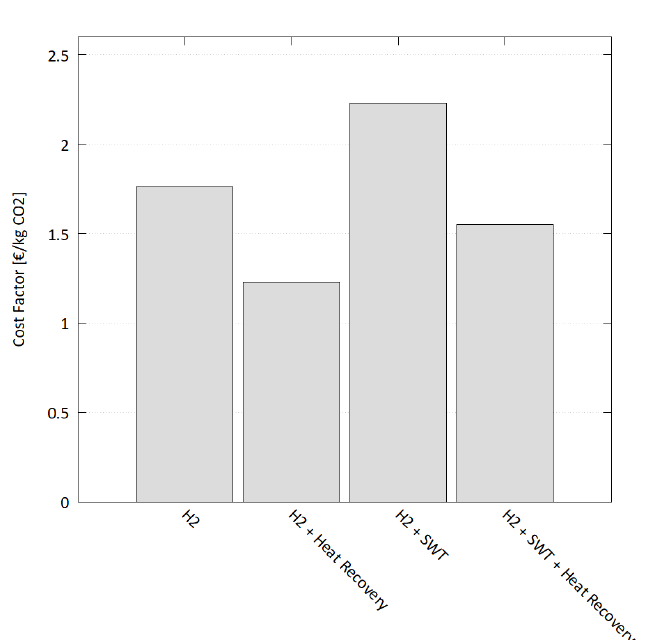
Figure 13. Annual progression of the hydrogen storage pressure.